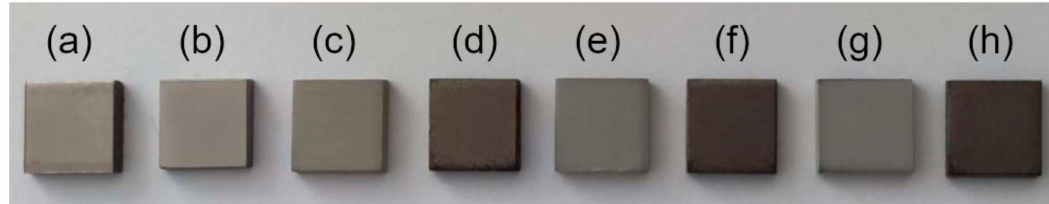
Figure 2. The photo of samples: ( a ) as received and after waterjet cutting; ( b ) after mechanical treatment with SiC sandpaper with a gradation of #1200 and after PEO: ( c ) TiZnCu-35; ( d ) TiZnCu-135; ( e ) TiZnCuCa-35; ( f ) TiZnCuCa-135; ( g ) TiZnCuMg-35; and ( h )